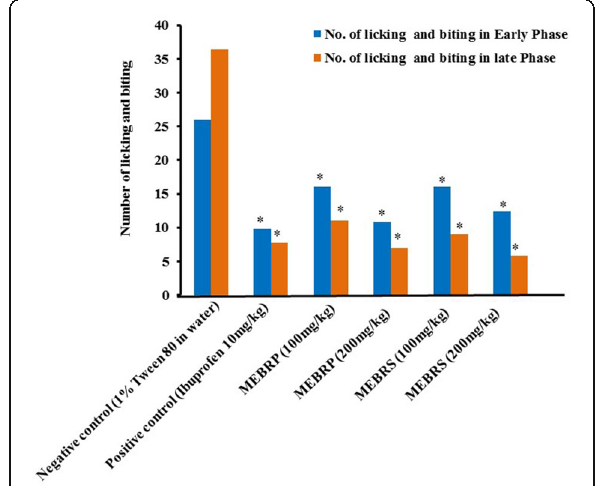
Fig. 2 Analgesic effects of the methanol extract of Baccaurea ramiflora pulp and seed on hind paw licking in the formalin test in mice. Values are means ± SEM of five mice ( n =5); * p <0.05 as compared to vehicle control (One way ANOVA followed by Dunnett ’ s test). Control mice received vehicle (1% Tween 80 in water); positive control received Ibuprofen 10 mg/kg body weight; tested animals were treated with 100 and 200 mg/kg body weight (p.o.) of the MEBRP and MEBRS, respectively